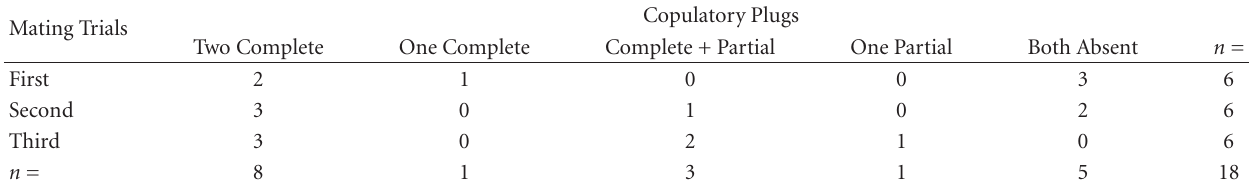
Table 3: Copulatory plug combinations for laboratory Peucetia viridans females who mated by order of mating trials. Mating Trials